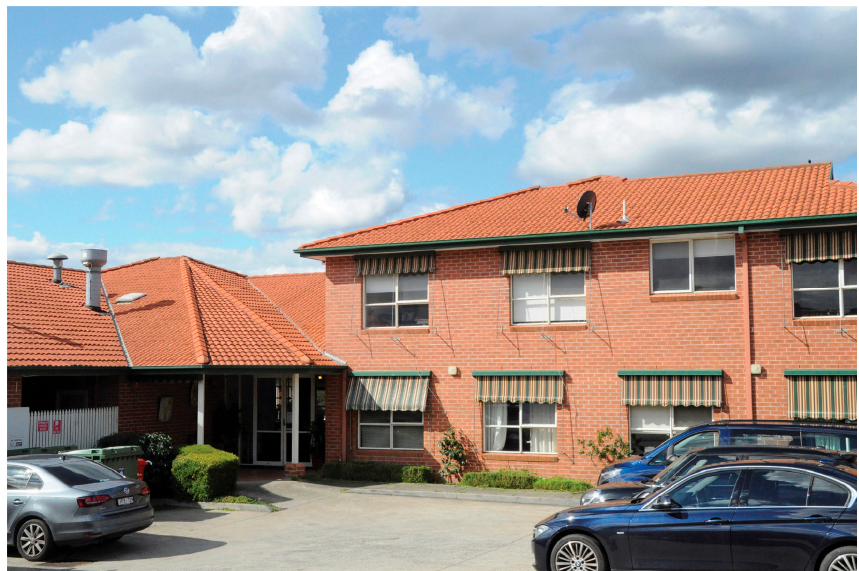
Figure 4. Exterior view of Adare SRS studied.